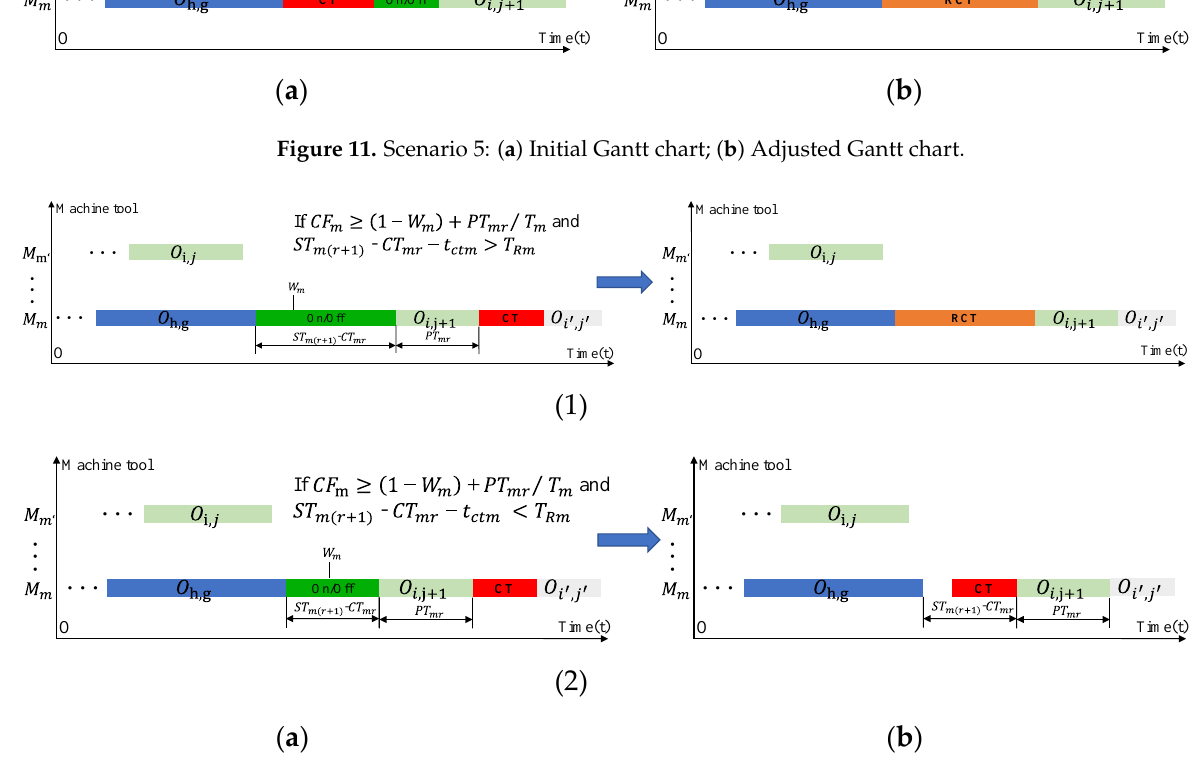
Figure 12. Scenario 6: ( 1 ) Sufficient machine-off time; ( 2 ) Insufficient machine-off time. ( a ) Initial